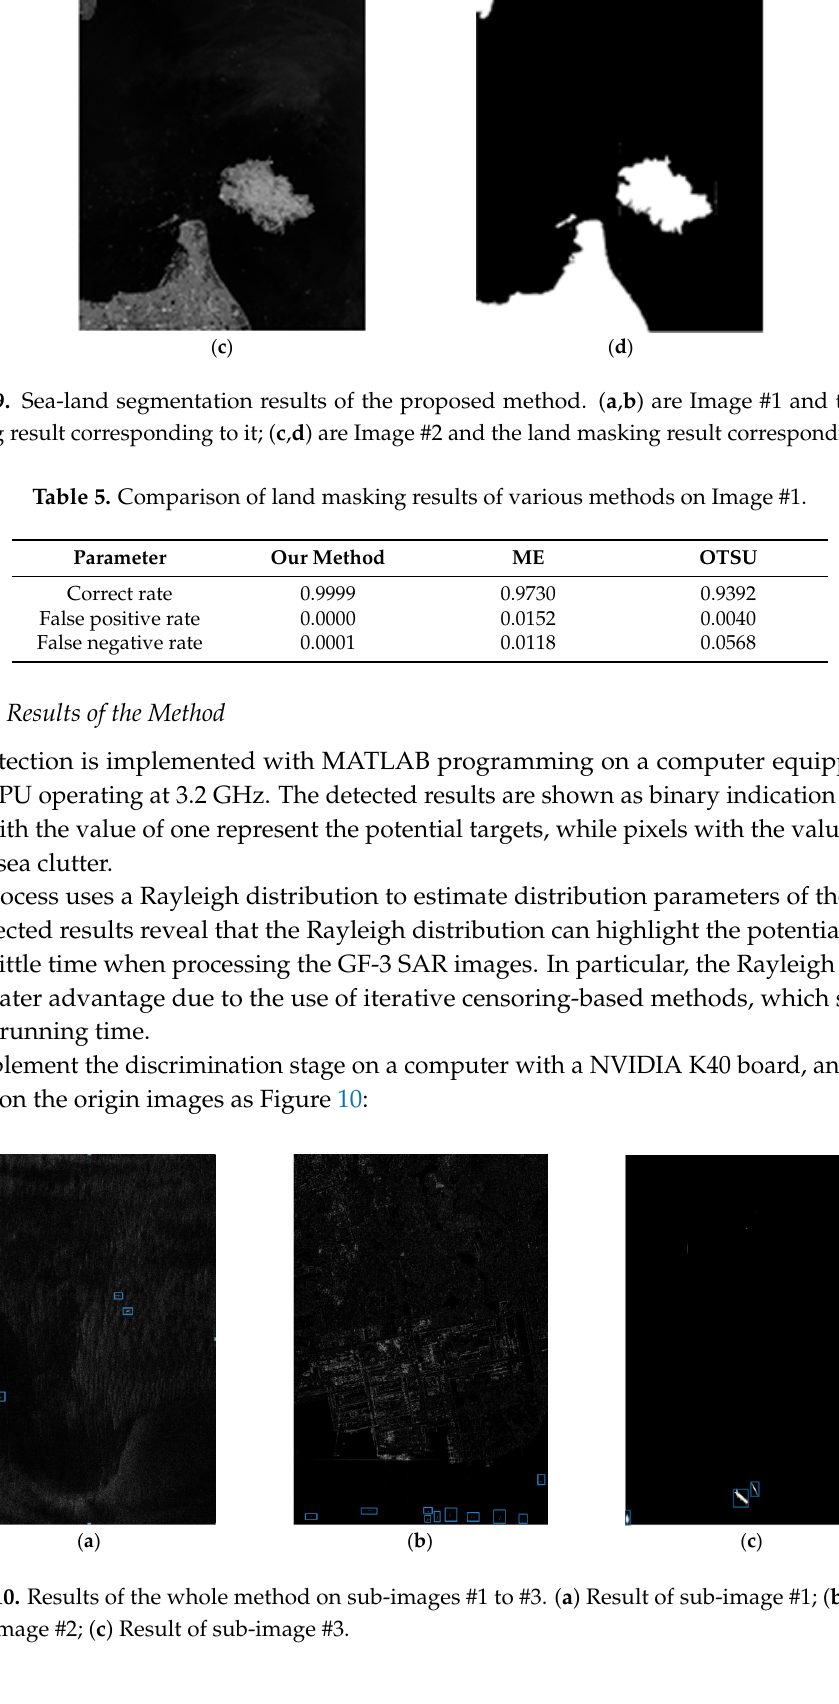
Figure 10. Results of the whole method on sub-images #1 to #3. ( a ) Result of sub-image #1; ( b ) Result of sub-image #2; ( c ) Result of sub-image #3.